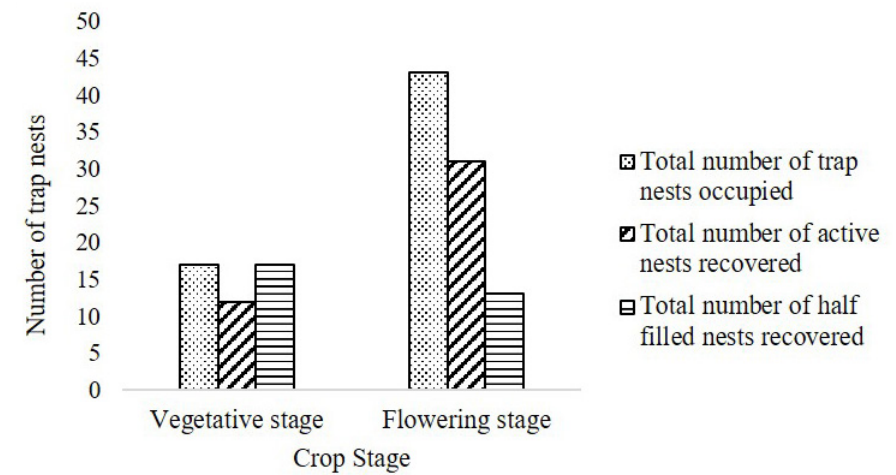
Fig 3 . Number of trap nests by leaf cutter bees Megachile Latreille, 1802 occupied at two different crop stages of Pigeon pea ( Cajanus cajan (L.) Millsp. Fabaceae) plantation of the experimental farm of ICAR- National Bureau of Agricultural Insect Resources (NBAIR) Bengaluru, Yelahanka Campus, India.